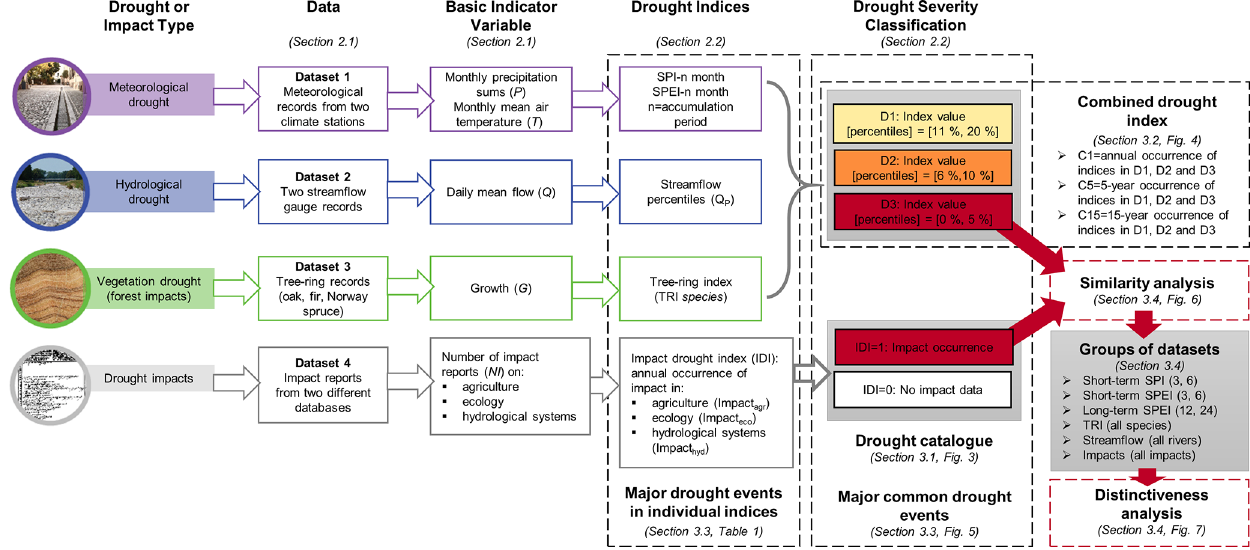
Figure 1. Conceptual overview of the multi-perspective approach of this study. The used multivariable dataset is shown, as well as the derived indices used to create the drought catalogue.